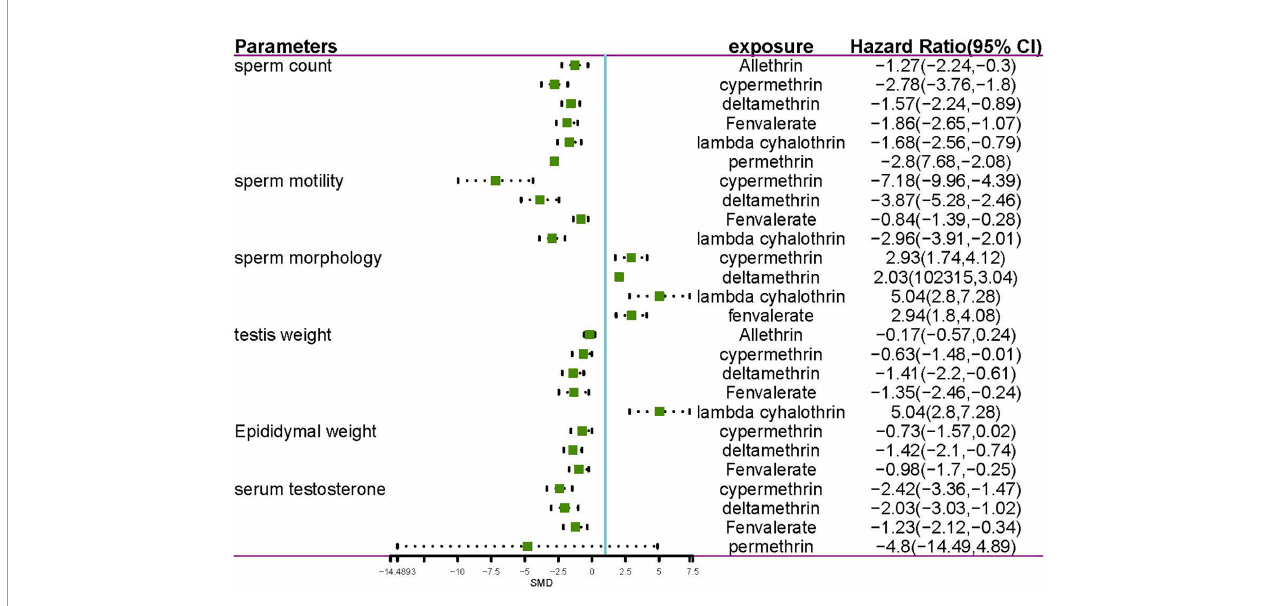
FIGURE 2 | Forest plot showing the effect of pyrethroid exposure on